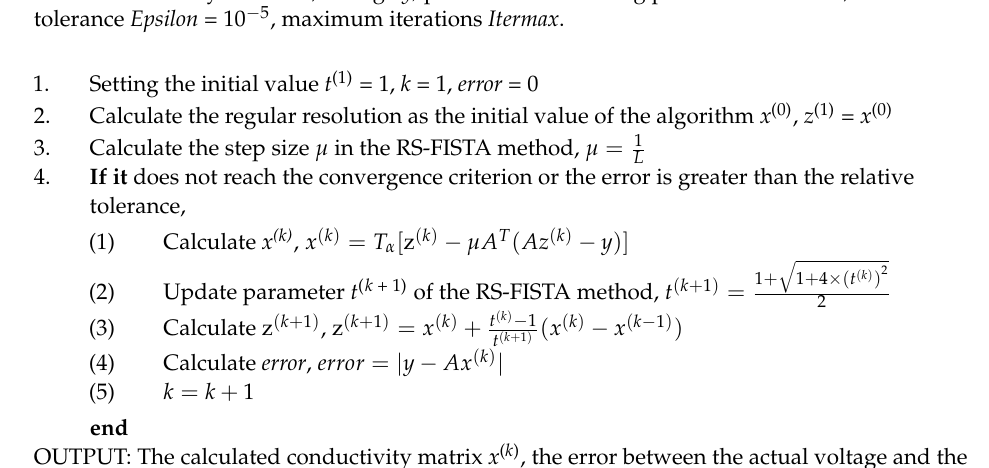
Algorithm 1 Regularization Solver Guided Fast Iterative Shrinkage Threshold